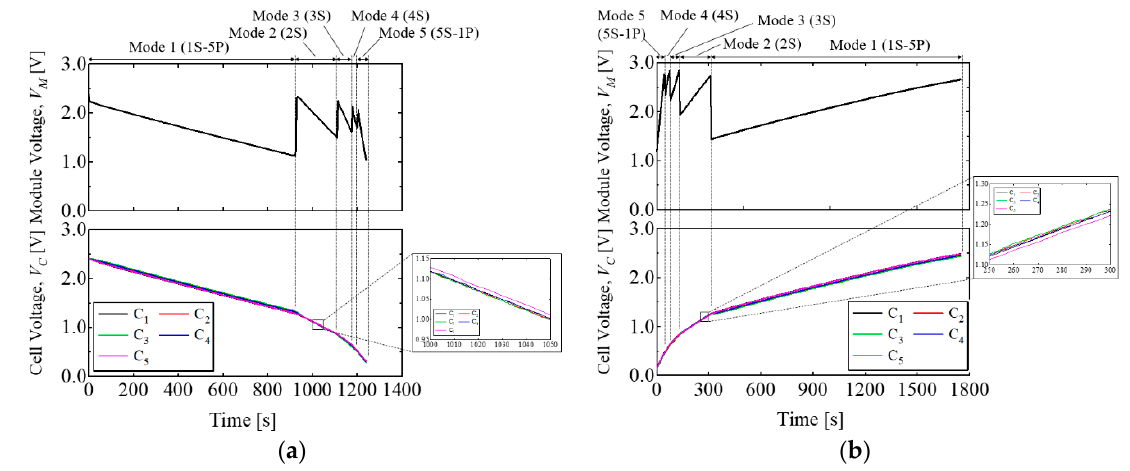
Figure 14. Resultant module and cell voltage profiles in ( a ) discharging and ( b ) charging processes.